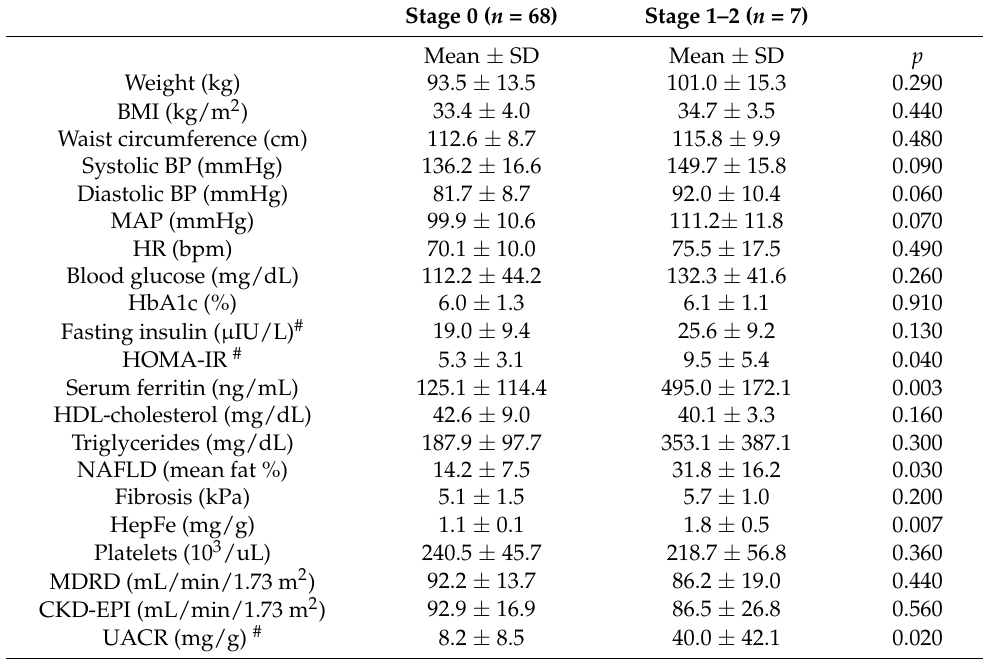
Table 5. Characteristics of the MetS, hepatic, and renal variables of the study population according to the stages of